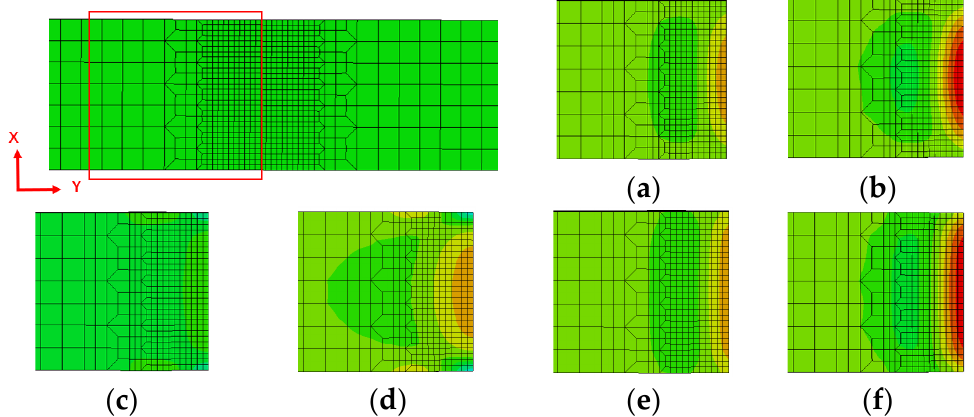
Figure 10. Stress field of cutting surface during the cooling process; ( a ) X stress with cooling time of 1 s; ( b ) X stress after cooling process; ( c ) Y stress with cooling time of 1 s; ( d ) Y stress after cooling process; ( e ) Z stress with cooling time of 1 s; ( f ) Z stress after cooling process.